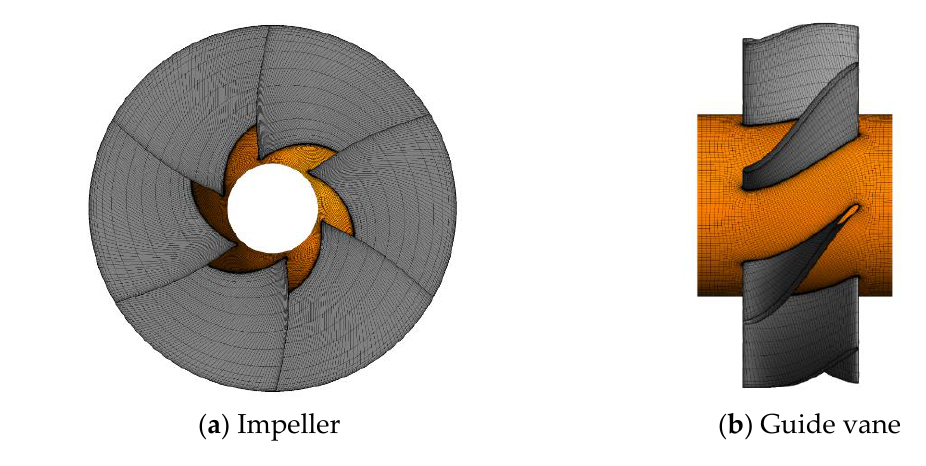
Figure 3. Computational mesh.